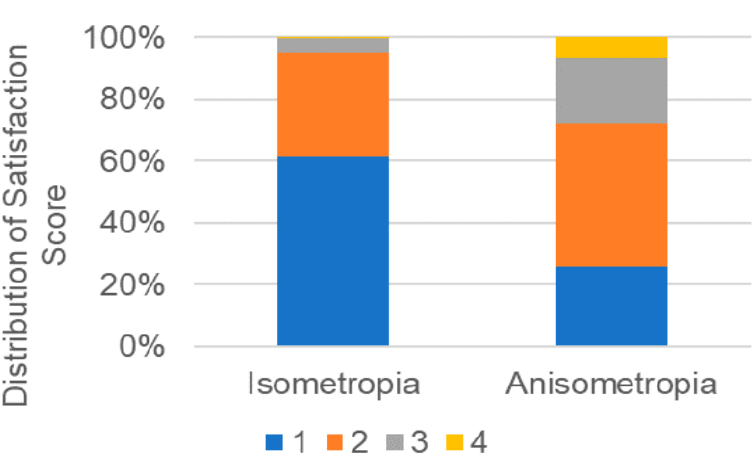
Figure 2. Distribution of final satisfaction score stratified by isometropia / anisometropia. Final satisfaction scores were significantly poorer in the anisometropia group ( p < 0.001, Mann-Whitney U